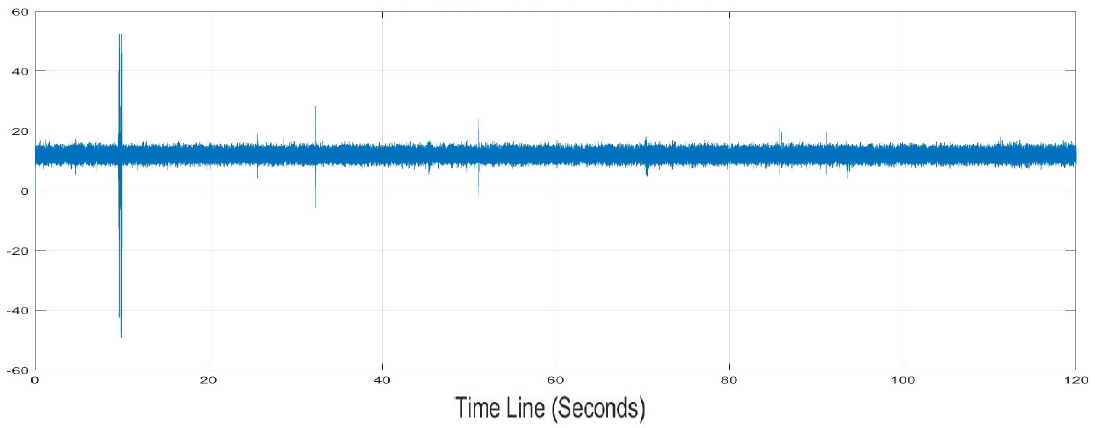
Figure 24. Original Time Series or RAW samples from USB-DAQ S .